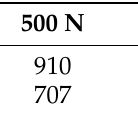
Table 4. Half dead